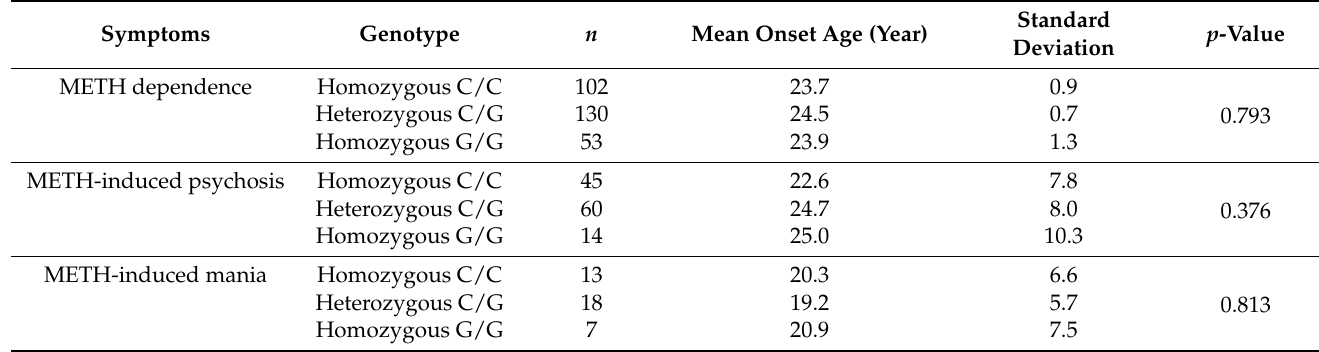
Table 7. The age of onset for METH dependence, METH-induced psychosis, and mania, according to